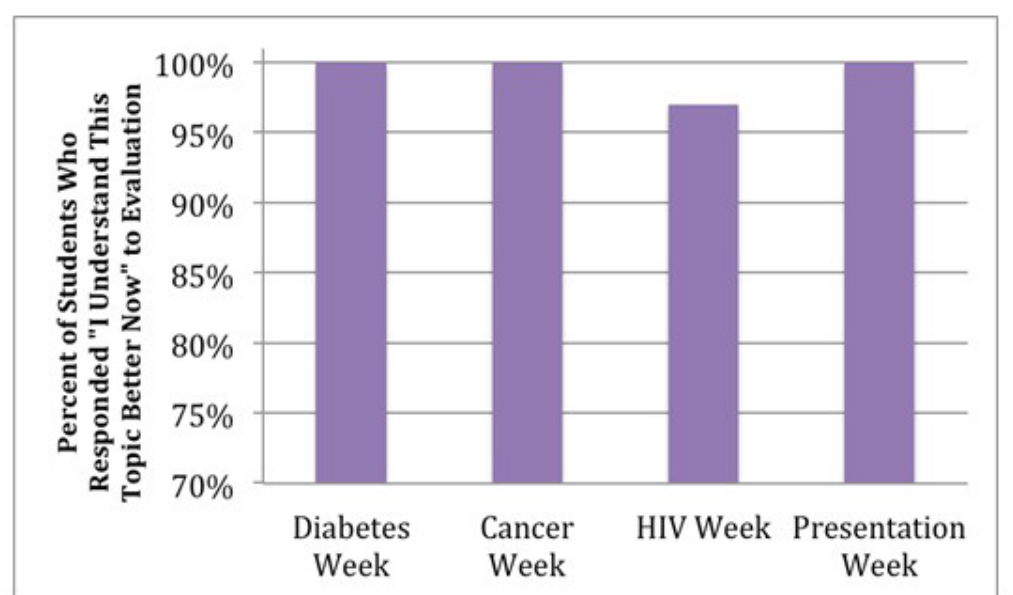
Figure 1. Percentage of students who responded “I Understand This Topic Beter Now” to